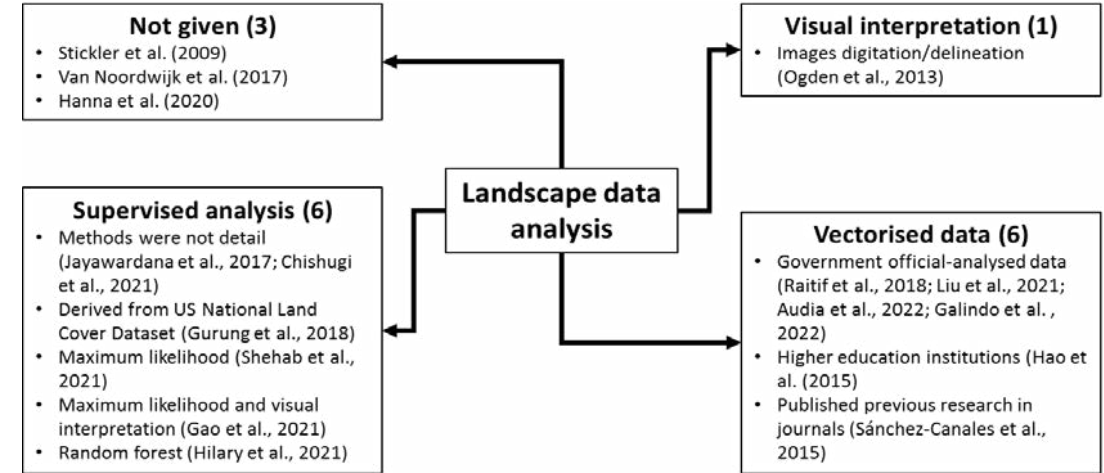
Fig. 2: Analysis method for landscape data